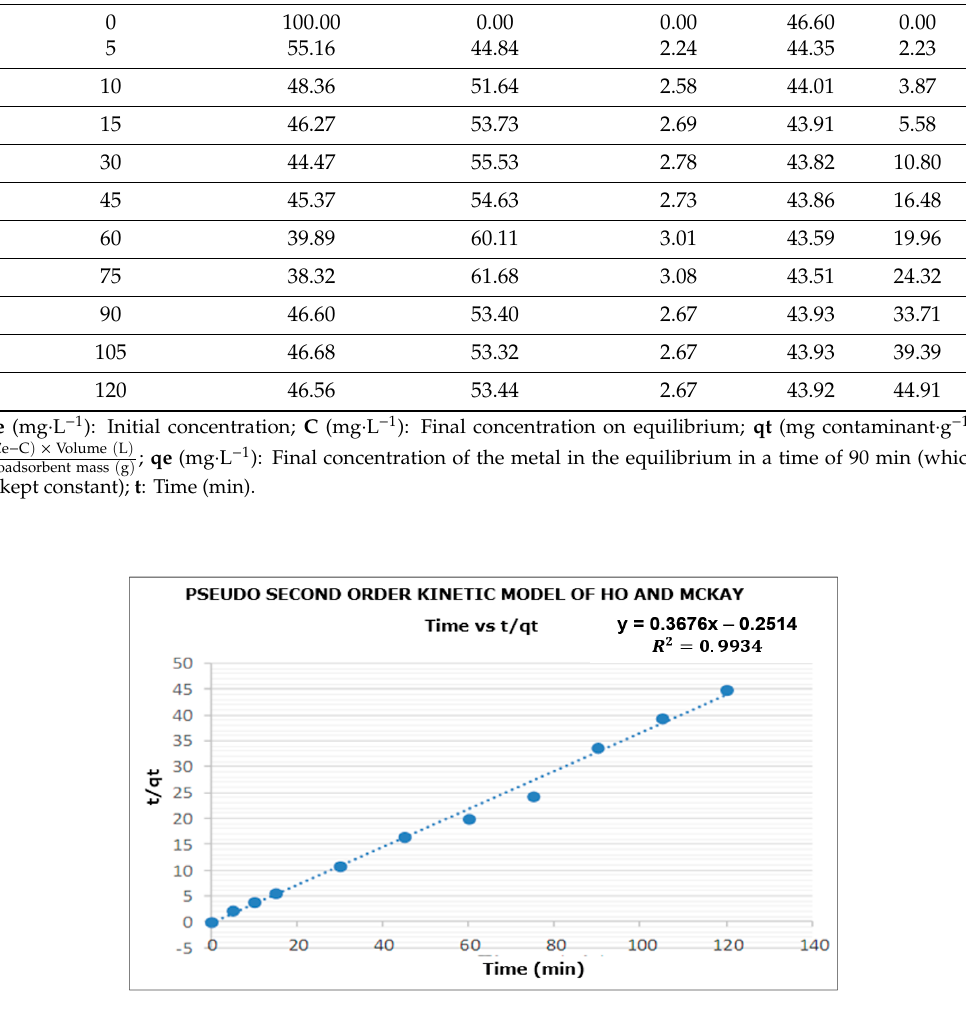
Figure 4. Ho and McKay pseudo-second-order model for adsorption of Mn (II) with CP.